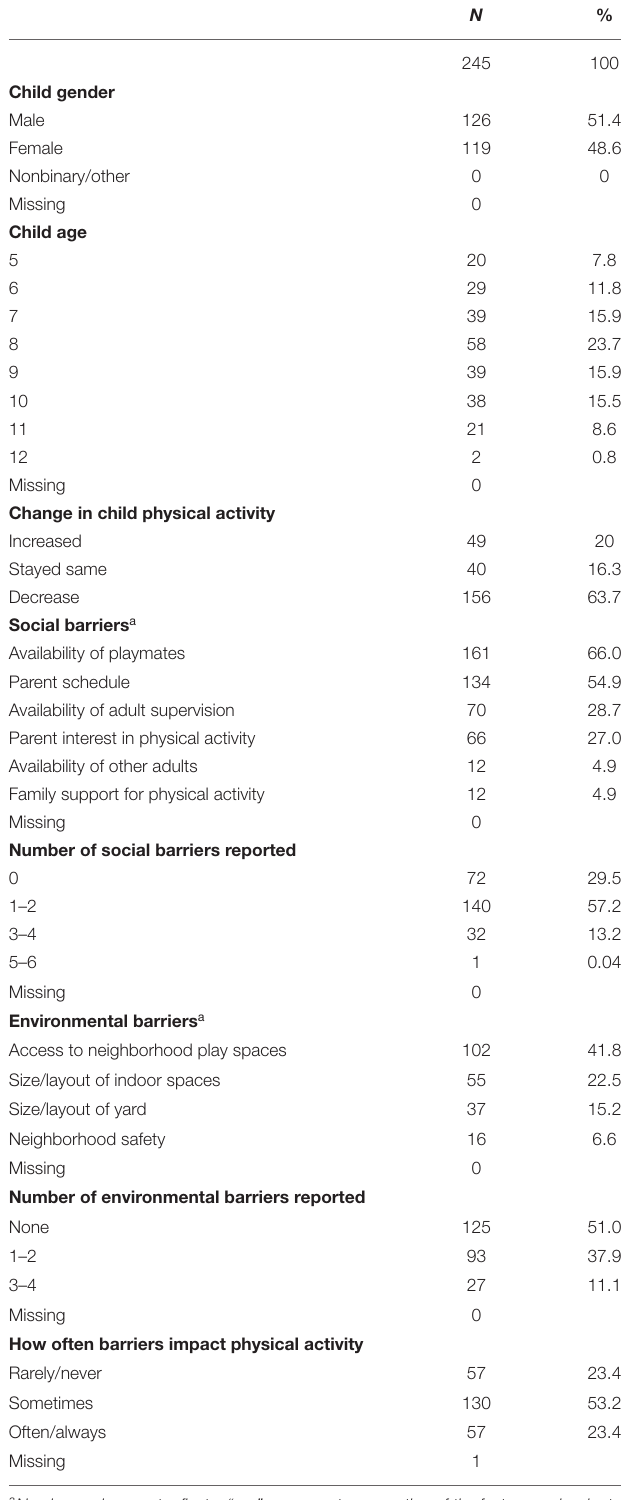
TABLE 1 | Descriptive data for demographic characteristics, physical and social environmental barriers to children’s physical activity during COVID-19 stay-at-home